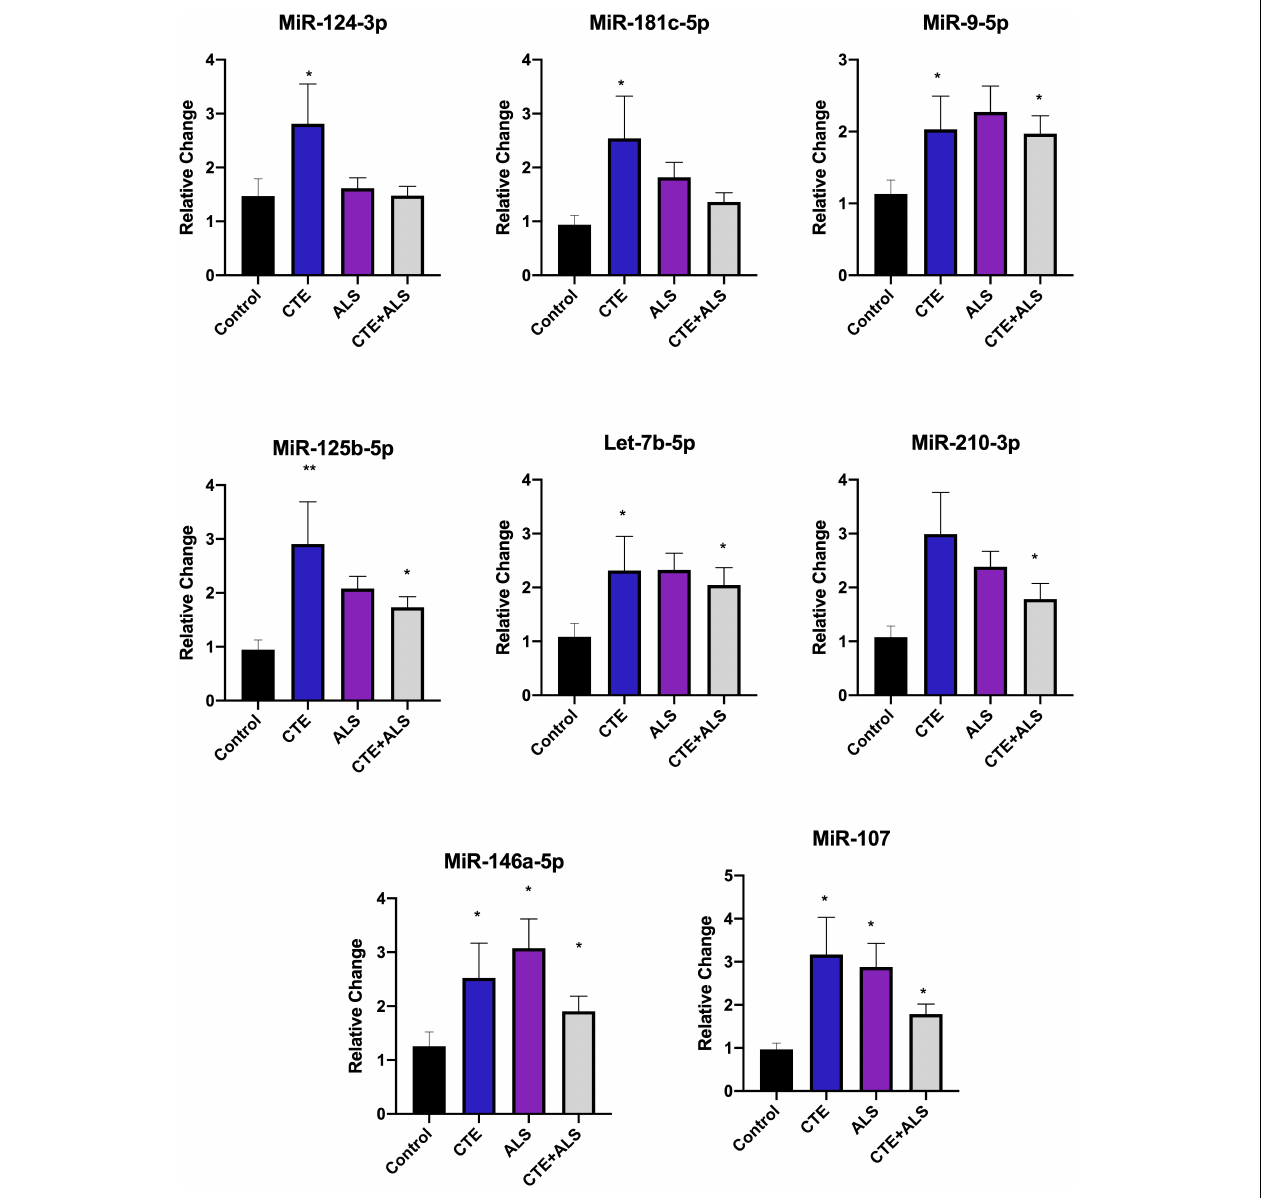
FIGURE 3 | Inflammatory miRNAs significantly altered in CTE, ALS, or CTE + ALS. MiR-124-3p, miR-181c-5p were significantly upregulated in CTE only. MiR-9-5p, let-7b-5p, miR-125-5p, let-7b-5p were significantly upregulated in both CTE and CTE + ALS. MiR-210-3p was significantly upregulated in comorbid CTE +